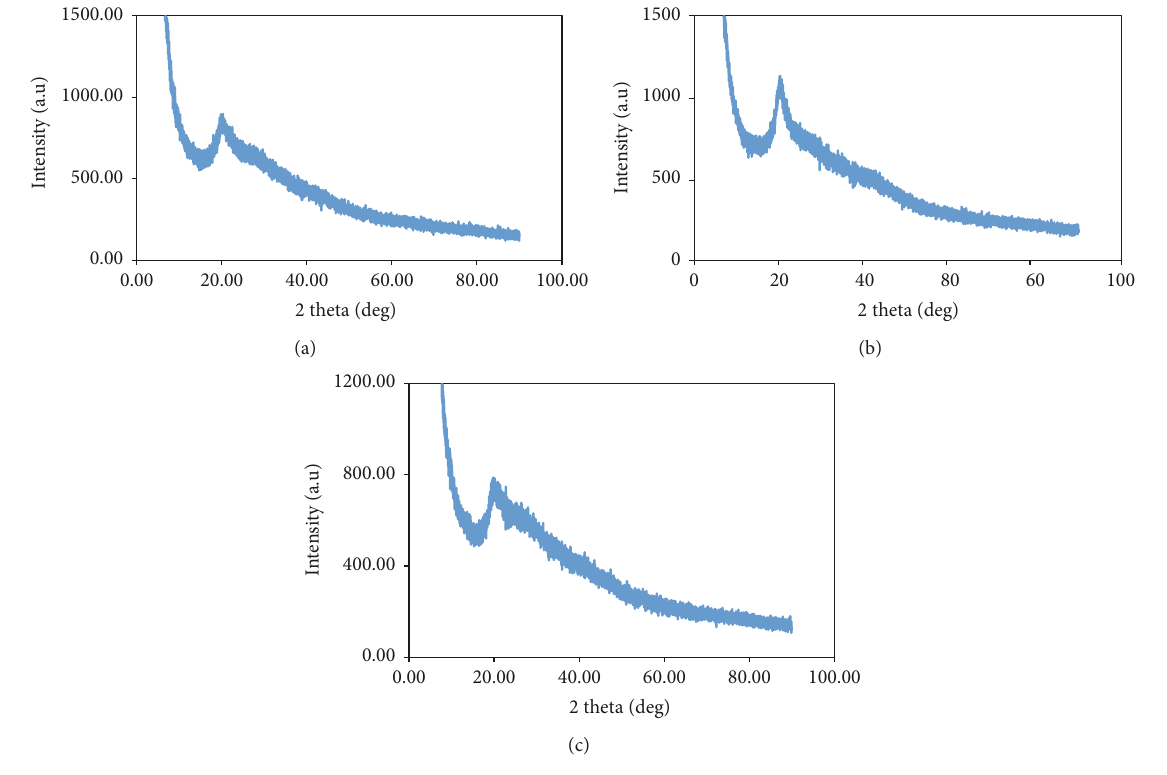
Figure 3: XRD of CX, CCX, and FGCX, respectively.